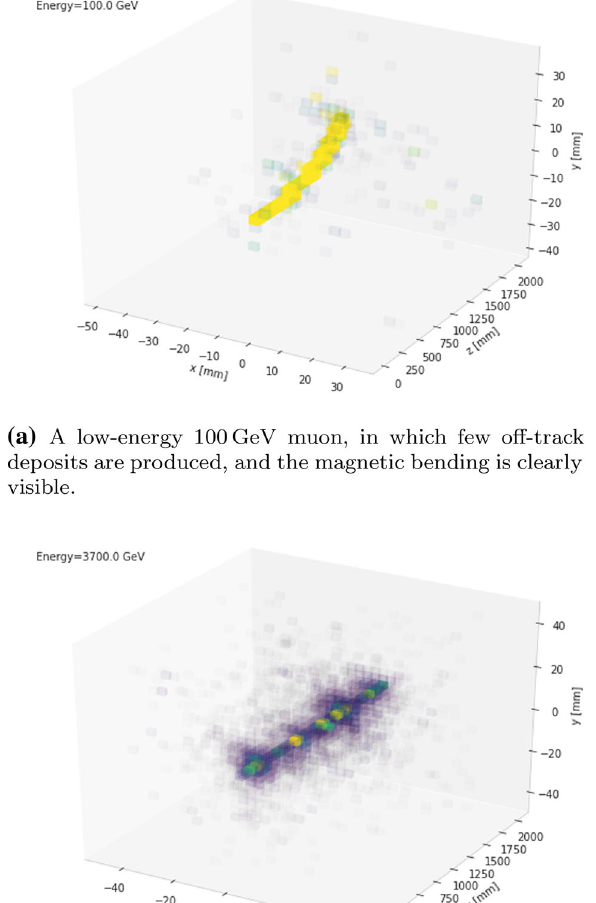
standsatransversedisplacementof1.24mmfromitsoriginaltrajectory, which is less than a third of a calorimeter cell.